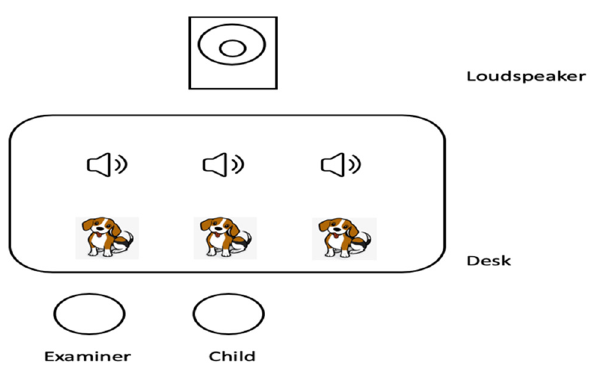
Figure 2. Diagram of the experimental scene. The loudspeaker is one meter away from the child. Each of the two blocks contained 60 trials. In both blocks, the offset F0s of the deviant stimuli were first started at 300 Hz and went downward and approached the standard stimulus (100 Hz) upon correct responses. Following the successful discrimination of the deviant stimulus in the first trial, the offset F0 change was set at 100 Hz for the second trial. Based on previous studies [20,30], the step size in each trial was adjusted to 5 Hz for the first three reversals and to 1 Hz thereafter. With the exclusion of the first three rever- sals, the average offset F0 change from the original one (300 Hz) was calculated from the last even number of reversals in the adaptive track. The JND for each condition was de- fined as the offset F0 difference between the average offset F0 change and the offset F0 of the standard stimulus (i.e., 100 Hz). The children were given practice trials before the test until they were familiarized with the task requirements. The order of the blocks of F0 contour and F0 level measurement was counterbalanced among the children. A break was given every four to six trials. 2.4. Statistical Analysis To investigate the effects of hearing experience (normal hearing vs. CIs) and F0 di- mensions on the sensitivity to F0 change, JNDs of F0 contour change and F0 level change were entered as the dependent variables in a two-way analysis of variance, with group (NH group/CI group) and F0 dimension (F0 level/F0 contour) as the independent varia- bles. A test of simple effects was conducted upon the significant interaction between group and F0 dimension. The Mann–Whitney U test was performed for the comparison between groups. To investigate the relationship between demographic factors (e.g., age at implanta- tion) and sensitivity to F0 change, Pearson correlation analyses were performed between JNDs of F0 contour/ F0 level change and demographic factors. The p -value of 0.05 was set as a threshold of statistical significance throughout all tests. 3. Results The JNDs of F0 contour and F0 level change in children with CIs and NH children are shown in Figure 3. On the whole, the JNDs of F0 change were larger in children with CIs than in their age-matched peers. Within-group comparison between the JND of F0 level change and the JND of F0 contour change revealed that, in the control group, the JNDs of F0 contour change were consistently larger than those of F0 level change, while in children with CIs, contrasting patterns were observed: 22 of the 30 children with CIs exhibited larger JNDs of F0 level change, 6 showed opposite patterns, and 2 demonstrated equal JNDs of F0 contour and F0 level change. The percentage of children exhibiting dif- ferent patterns of JNDs of F0 level change and F0 contour change for each type of speech processing strategy is shown in Table 2.